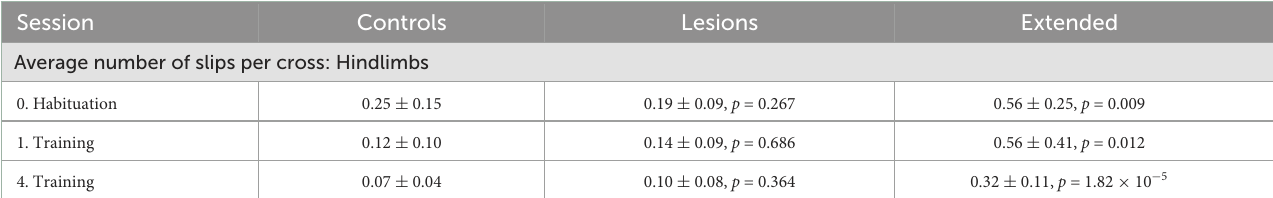
TABLE 5 Average number of hindlimb slips per crossing of each group for sessions with stable obstacles (mean ± standard deviation, p -values report Student’s unpaired t -test against the control group). Session Controls Lesions Extended Average number of slips per cross: Hindlimbs